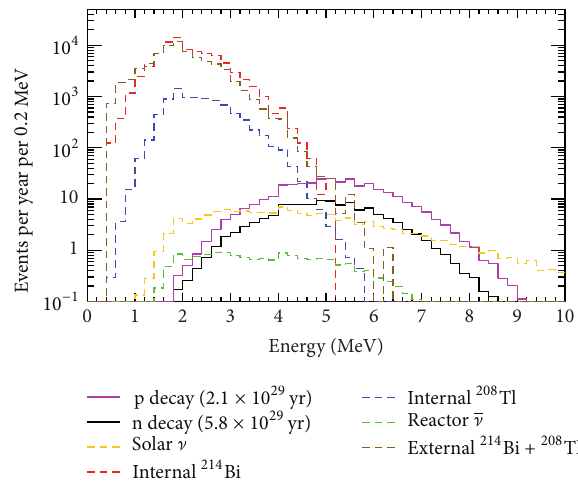
Figure 10: Expected energy spectrum for the water phase back- grounds. The signal from invisible proton [76] and neutron [78] decay is also shown. A fiducial radius cut of 5.5 m and a cut > −0.8 are on cos 𝜃 sun